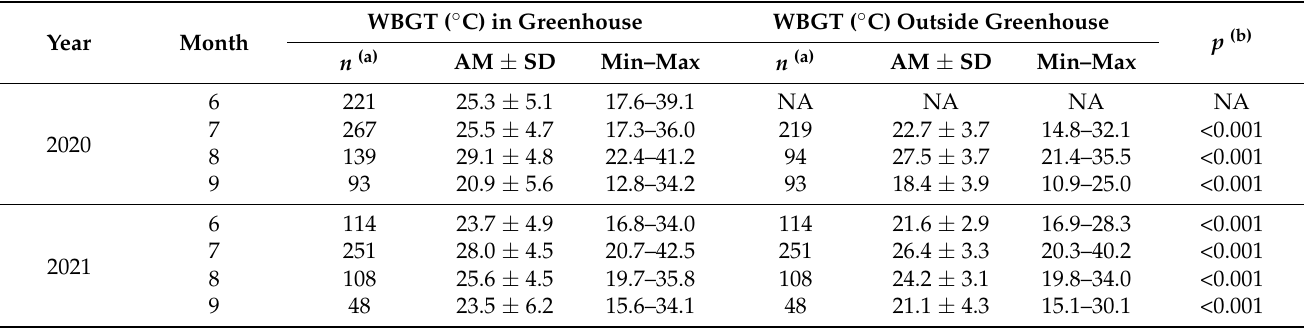
Table 3. WBGT indices inside and outside greenhouses.